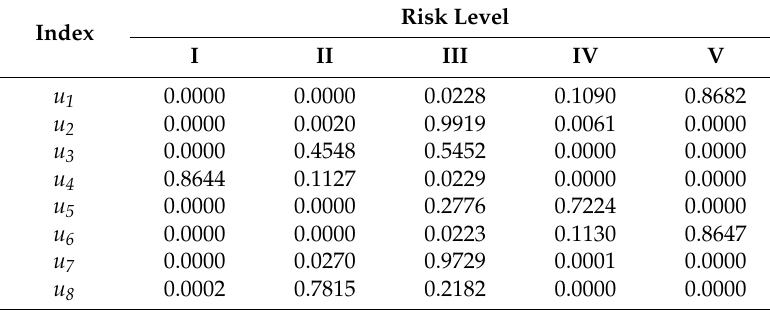
Table 19. Certainty degrees of Liupanshui City in Guizhou province.